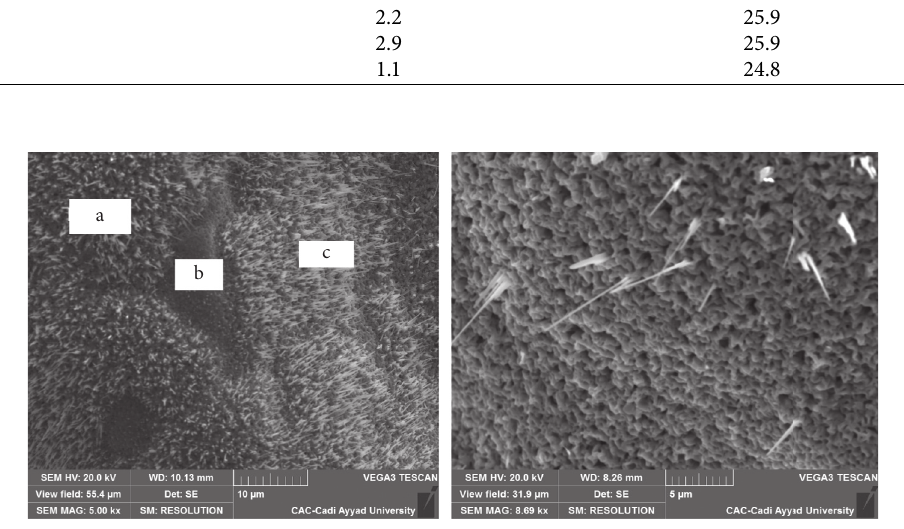
Figure 2: SEM images for the sample synthesized at 5 ° C/min (left)- a: dilute island; b: NWs finished being broken; and c: dense island; the sample synthesized at 15 ° C/min (right). The lack of homogeneity and the NWs breaking are caused by the thermal shock-induced in-plane tensile stresses.